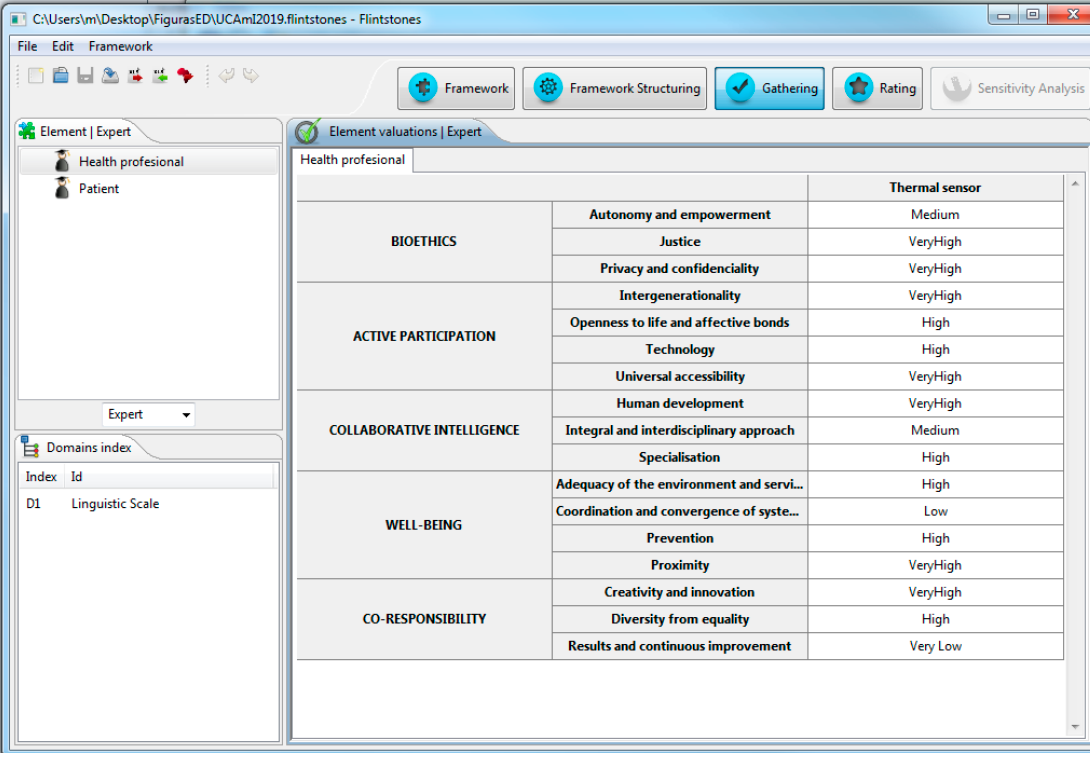
Figure 2. Gathering information with Fuzzy LINguisTic deciSion TOols enhaNcEment Suite